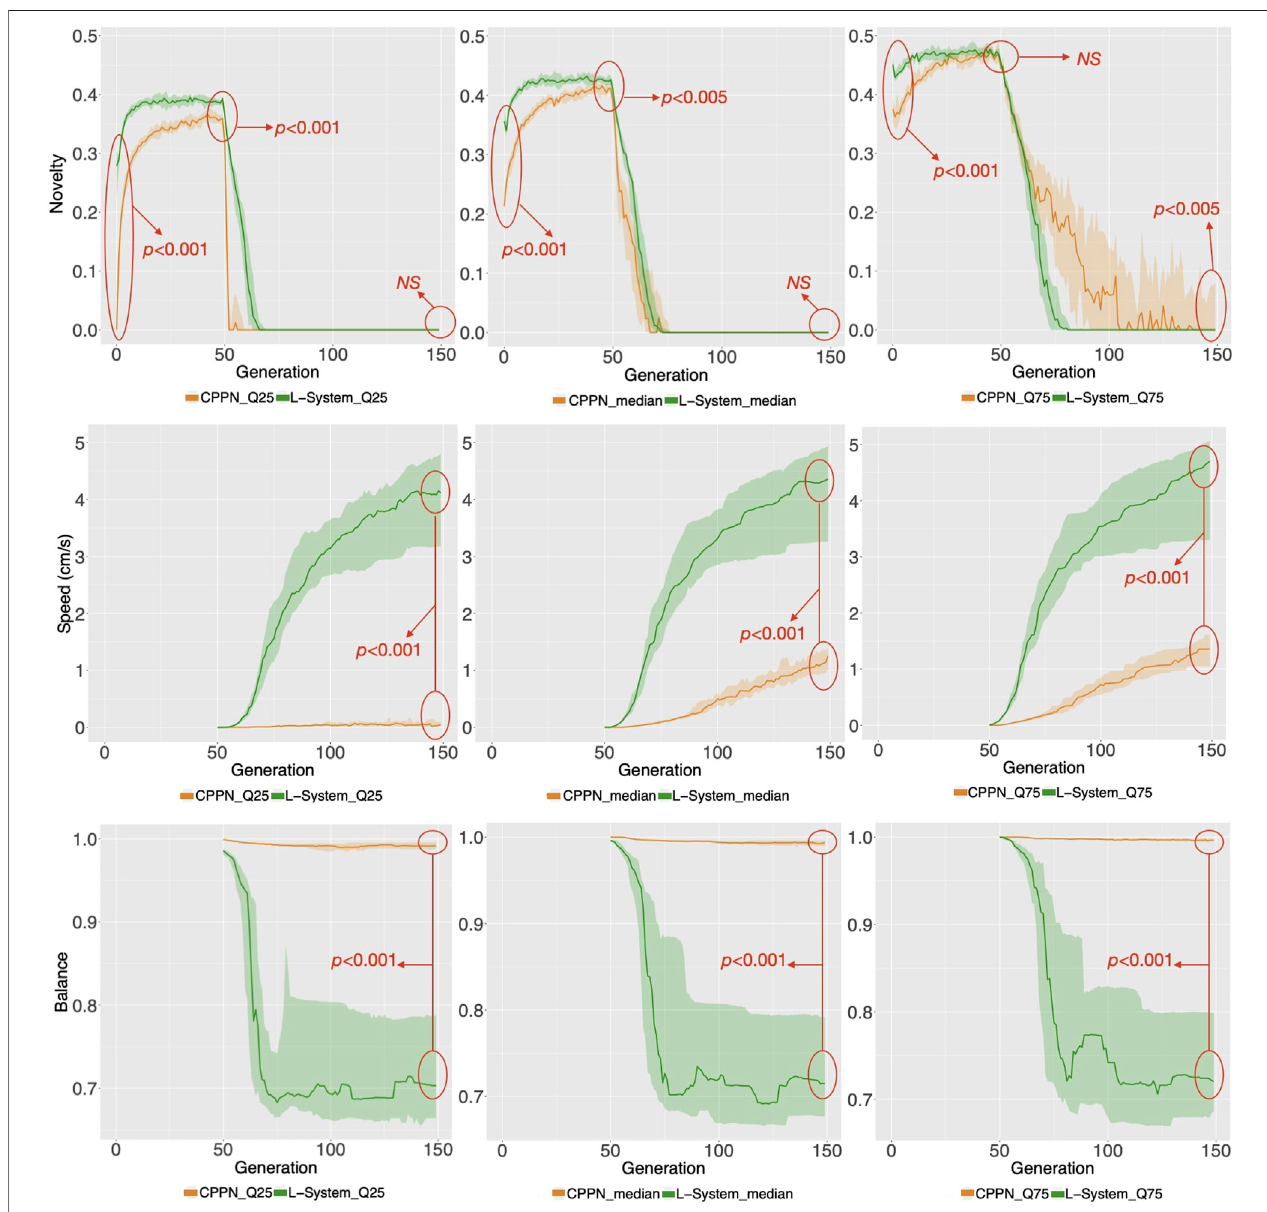
FIGURE4| Distributionsofnoveltyandbehavioraltraitsforthepopulations.Theaggregationofmeasureshappensintwolevels:Firstly,theplotsontheleft,middle, and right regard aggregations within the population of each run using the fi rst quartile, median, and third quartile respectively. Secondly, the lines represent the median amongtherunswhile thecloudsarounditrepresent their fi rstand thirdquartile. Theredarrows point tothe p valuesofWilcoxontests comparing thetwoencodingsina given generation. NS means non-signi fi cant. Note that there is no behavioral data before generation 50, when robots were evolved for morphological novelty only.